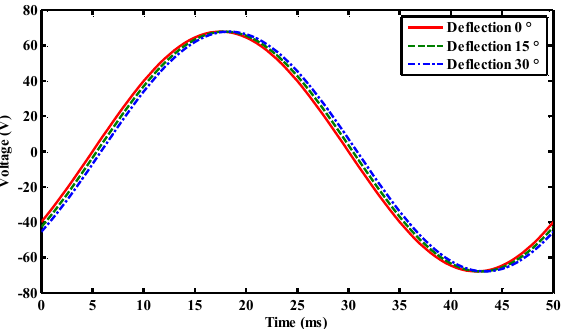
Figure 23. Voltage comparison diagram of phase A winding in three states.